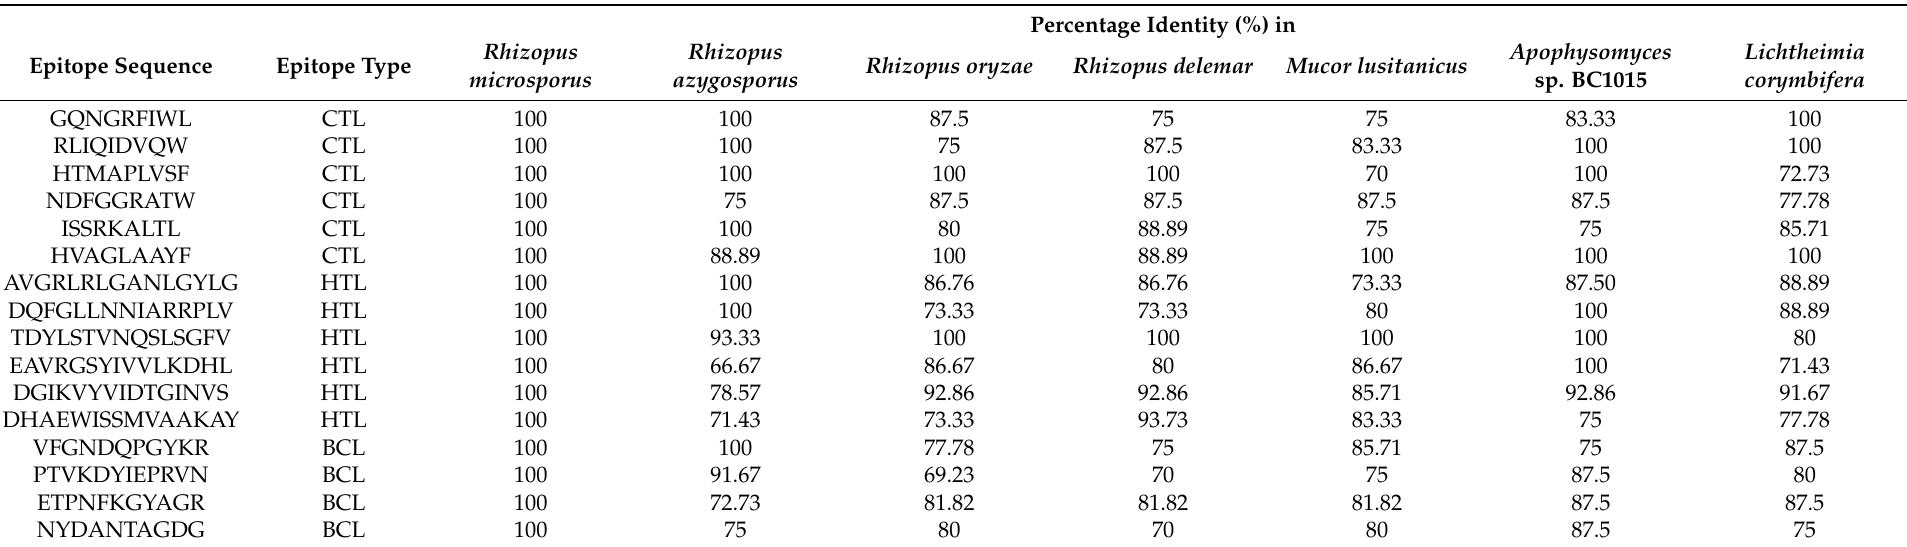
Table 6. Conservancy analysis of top-ranking epitopes in several mucormycosis-causing